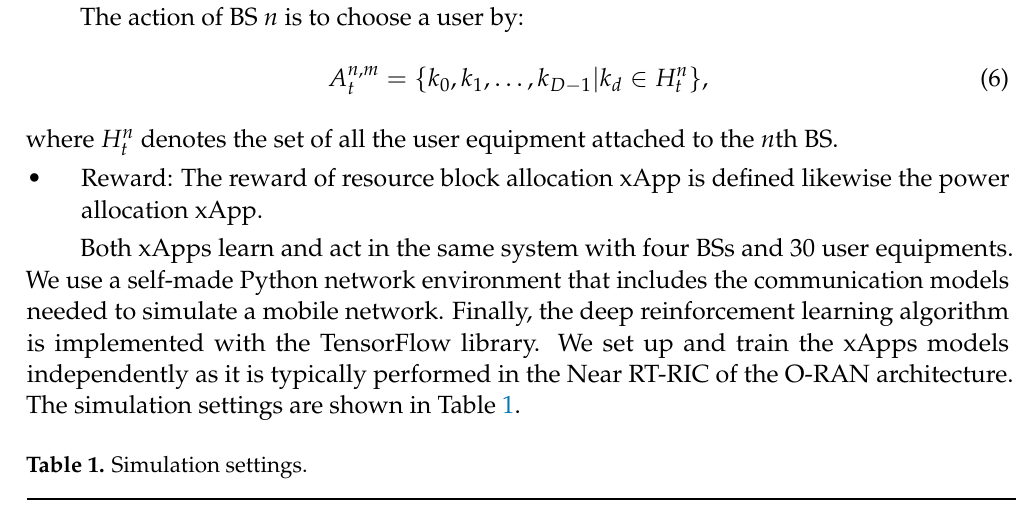
Table 1. Simulation settings. Parameter Value 4 Base Stations with 1 kilometre inter-site Networking Environment distance, 30 user equipments. 120.9 + 37.6 log10(distance) dB, Propagation Log-Normal shadowing: 8 dB. 20 MHz bandwidth, 100 resource Carrier configuration